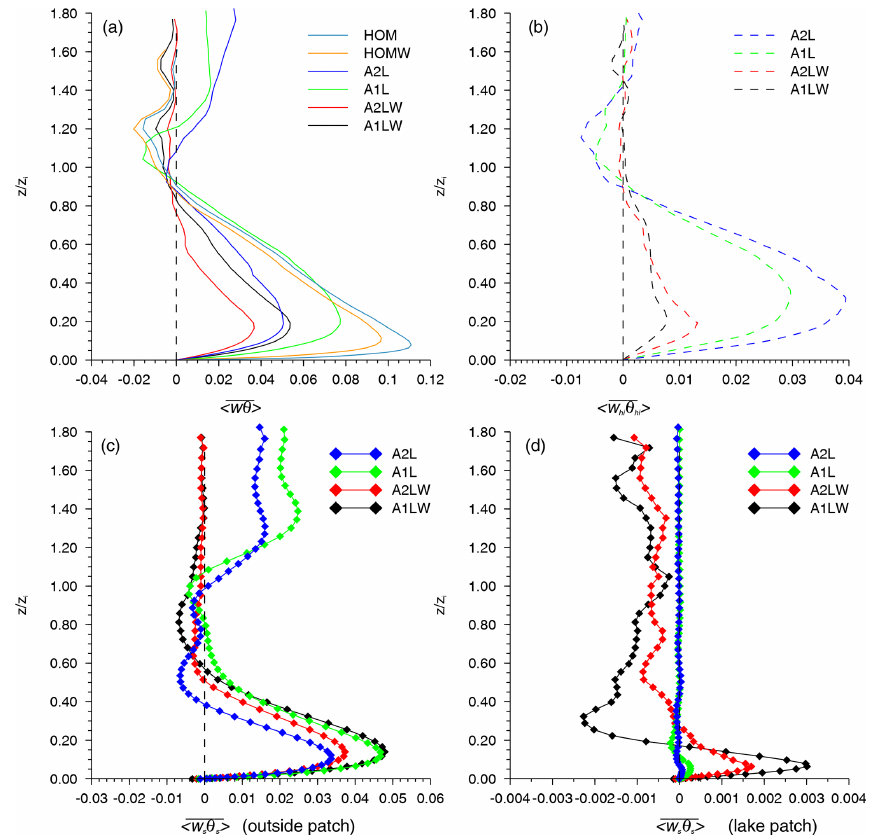
Figure 10. (a) Area-averaged total turbulent heat flux (solid lines) and (b) heterogeneity-induced turbulent heat flux (dashed lines). The background turbulence (lines with diamond symbols) of heat flux over the grassland (c) and lake patches (d) . Table 3. The maximum and minimum vertical velocities at the top of the boundary layer in cases A1LW, A2LW, A1LWC, A2LWC, A1LNG, A2LNG, A1L, A2L, A1LC, A2LC, HOM and